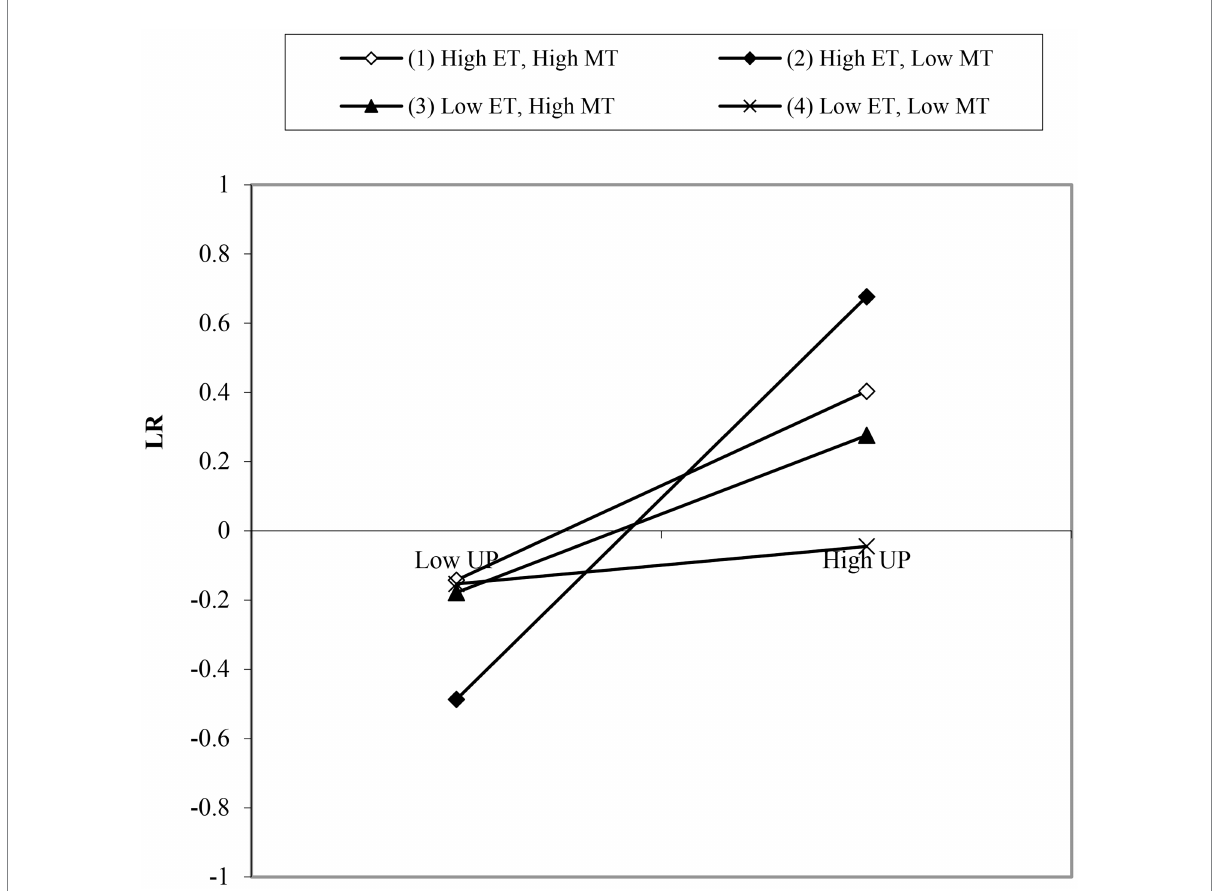
FIGURE 2 Moderating effects of employee–union trust and management–union